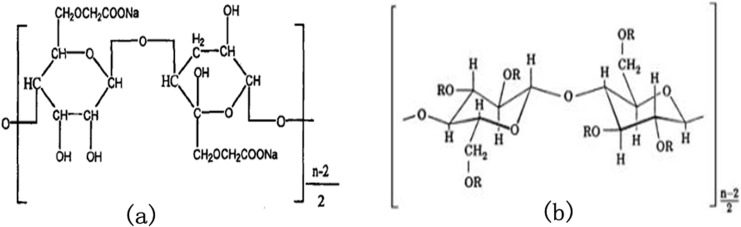
Molecular structures of PAC (a) and HPMC (b). The substituent R of HPMC molecular represents either a–CH3, or a–CH2CH(CH3)OH, or a hydrogen atom.